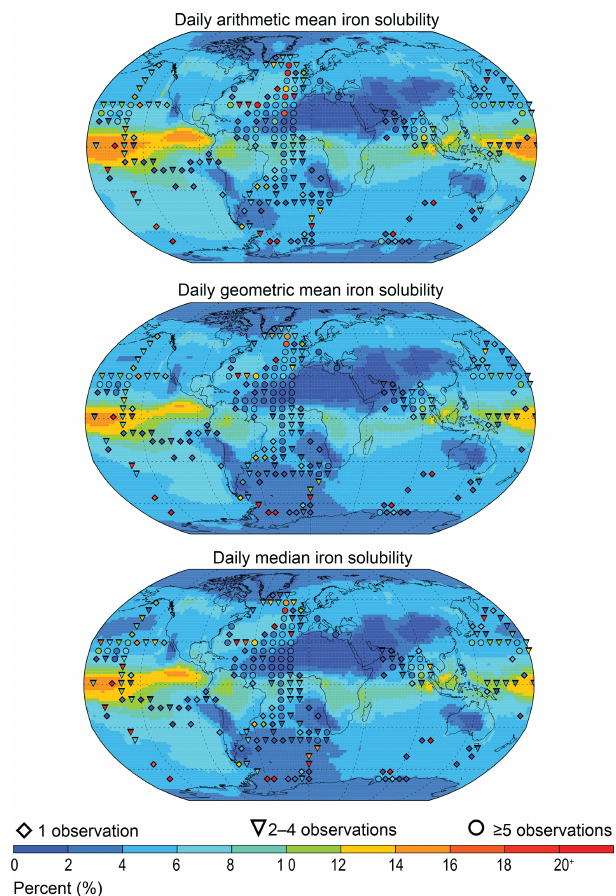
Figure 7. Daily arithmetic mean, geometric mean, and median model solubility (2007 to 2011). Observations are overlaid (at res- olution one-third of the model grid) as the arithmetic mean, geo- metric mean, or median with respect to the model averaging. The number of observations is denoted by symbols: lowest confidence (one observation, diamond); intermediate confidence (two to four observations, triangle); highest confidence (five or more observa- tions,